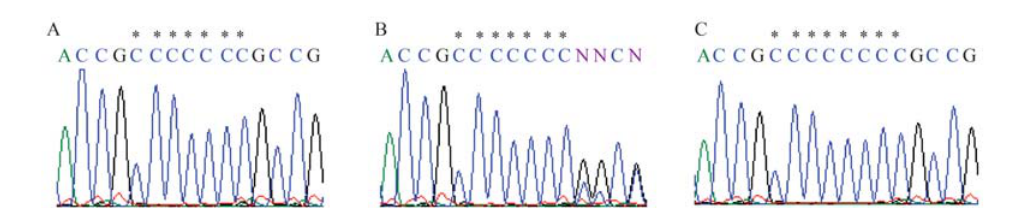
Figure2 -Apoly(C)polymorphismof p53 atpositions-824to-818.(A-C)GenomicDNAwasamplifiedbyPCRwithaforwardprimeratpositions-918 to -899 and a reverse primer at -669 to -690 of the p53 gene. Nucleotide sequences were determined by directly sequencing the PCR products; these se- quencing reactions were performed using a primer at positions -918 to -899. (*) shows homozygous (A and C) or heterozygous (B) nucleotides at posi- tions -824 to -818 in the p53 promoters, where “NNCN” in (B) indicates sequences including “GCCG” and “CGCC,” which result from nucleotide C in- sertion. Nucleotides around the poly(C) polymorphic position (*) are indicated.